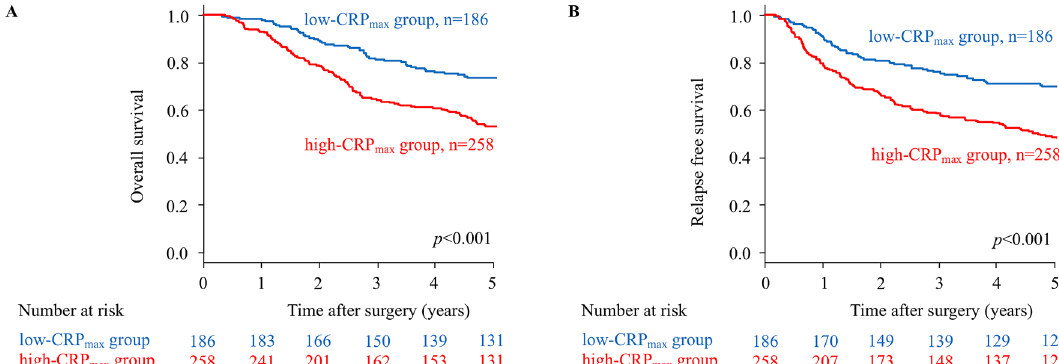
Figure 1. Kaplan–Meier survival curves of overall survival (OS) and relapse-free survival (RFS) according to CRP max in patients with stage II/III gastric cancer. ( A ) The five-year OS rates are 66.1% in the low-CRP max group and 45.6% in the high-CRP max group ( p < 0.001). ( B ) The five-year RFS rates are 63.5% in the low-CRP max group and 44.4% in the high-CRP max group ( p < 0.001).